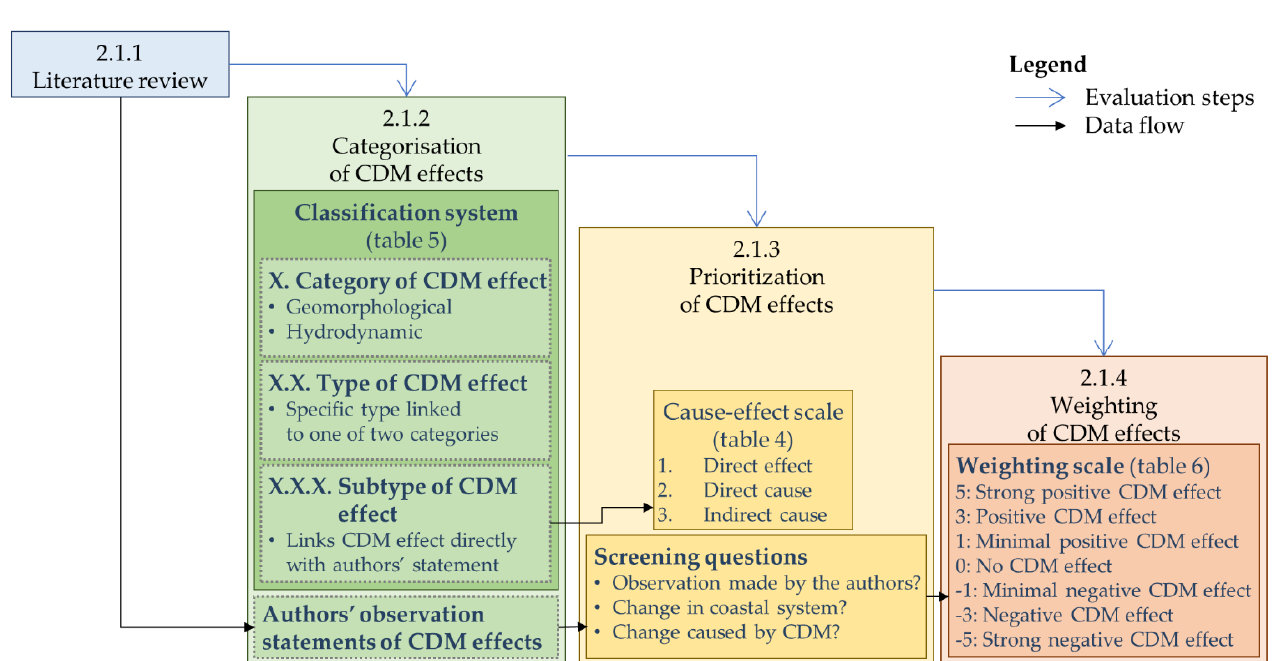
Figure 2. Logical schema for the evaluation of authors’ observation statements of the effects of CDMs.